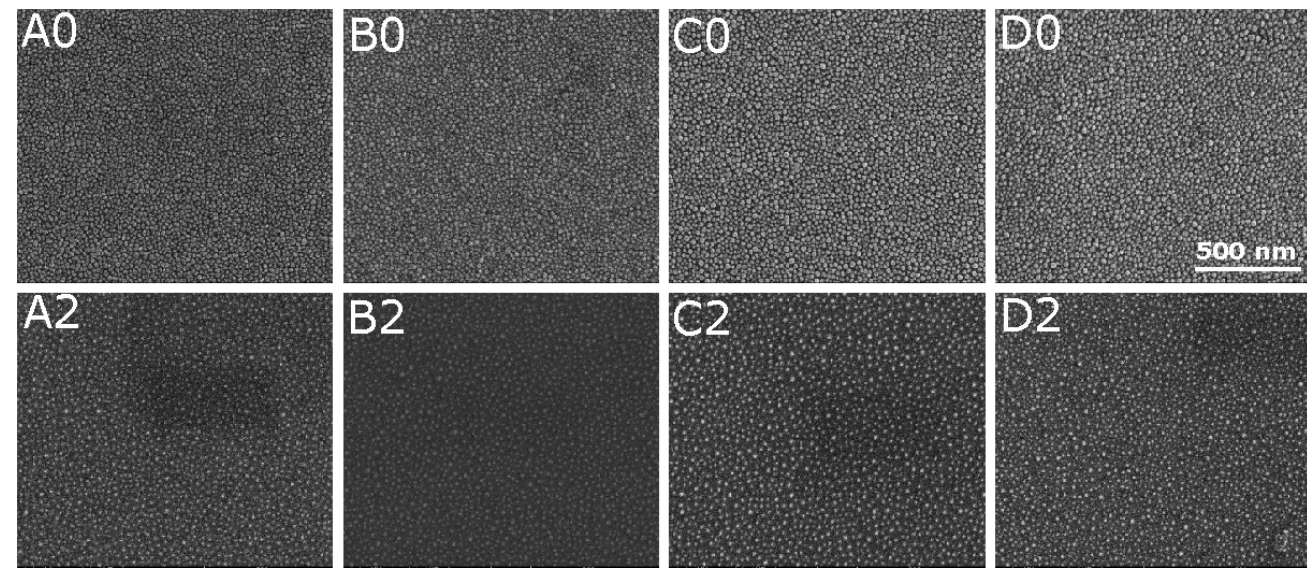
Figure 2. SEM images of the produced samples: as-prepared samples (X0) and samples heated at 200 ◦ C and then oxidized at 800 ◦ C (X2), where: X = A, B, C or